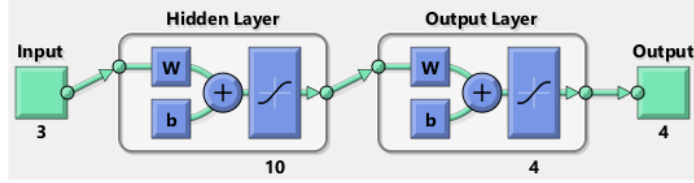
Figure 16. Multi-layer and forward-flow ANN.